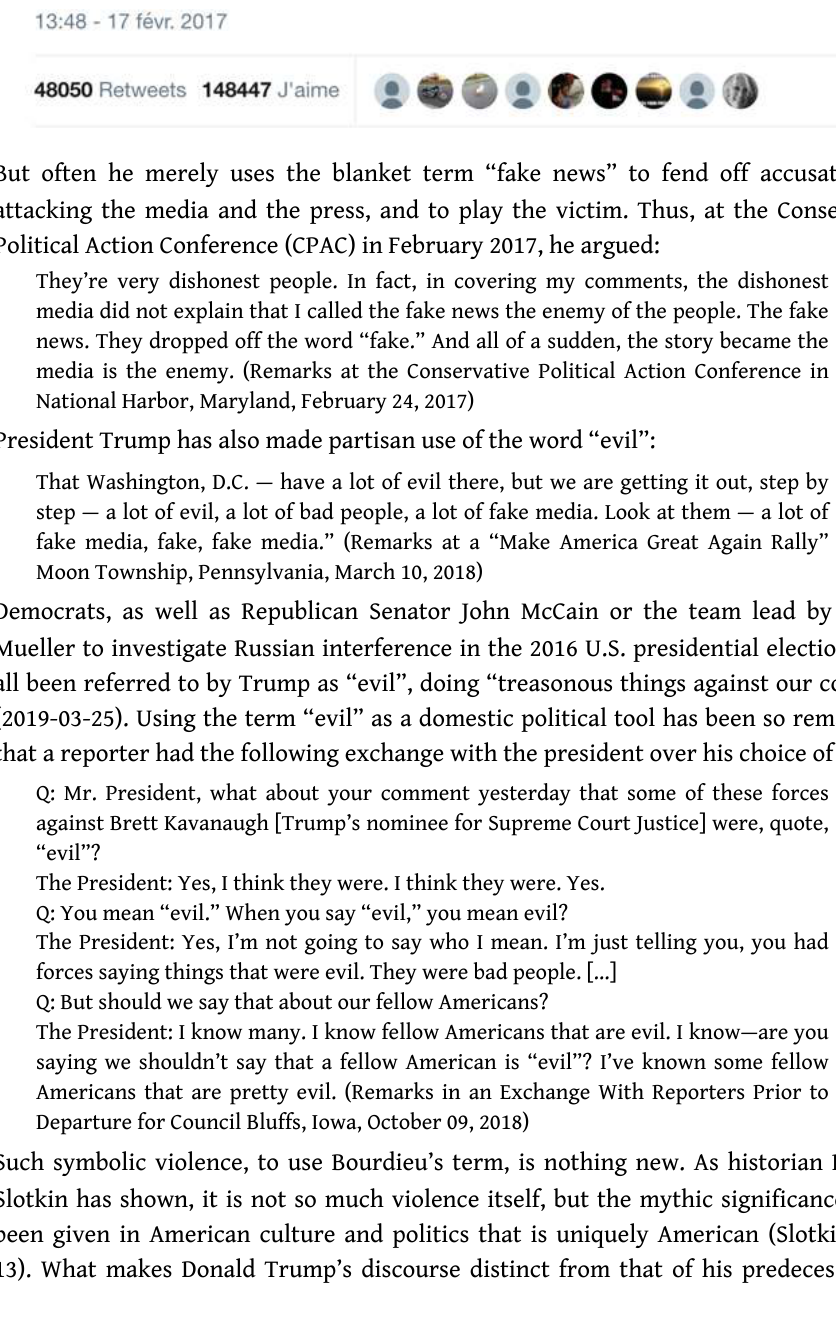
Figure 4. Tweet by Donald Trump attacking major U.S. press outlets as “enem[ies] of the American people” on February 17,